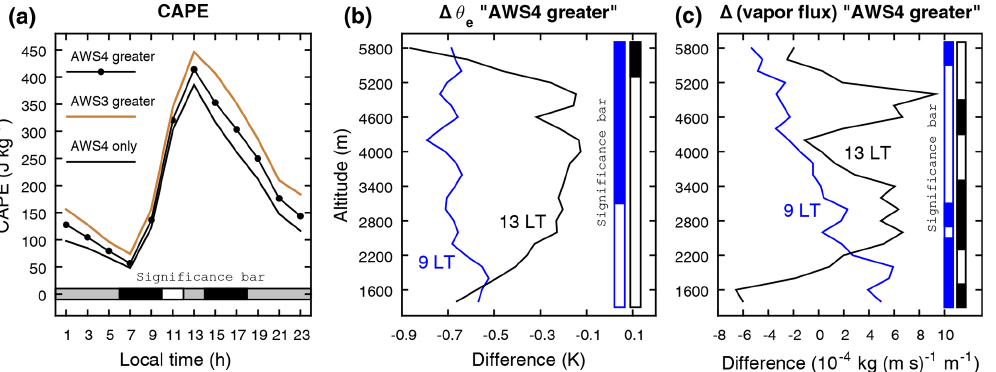
Figure 13. Modeled differences between days with higher solid precipitation measured at AWS4 or AWS3 between 8 October 2009 and 30 September 2013 on Kibo’s southern slope. (a) Mean diurnal cycle of the local maximum CAPE for days with greater amounts at AWS4 than AWS3 ( n = 502d), the opposite case ( n = 340d), and precipitation at AWS4 but none at AWS3 ( n = 341d). (b, c) Mean differences in 2m θ e and (absolute) vertical water vapor flux, “AWS4 greater” days minus “AWS3 greater” days, for 09:00LT (blue) and 13:99LT (black) versus elevation (200m bins). Horizontal and vertical bars in all panels identify the hours when differences are significant at the 5% level (fill) in both a two-tailed Wilcoxon rank sum and Kolmogorov–Smirnov test; in (a) this bar distinguishes between AWS4 greater vs. AWS3 greater (black fill) and AWS3 greater vs. “AWS4 only” (grey fill; partly covered by the black